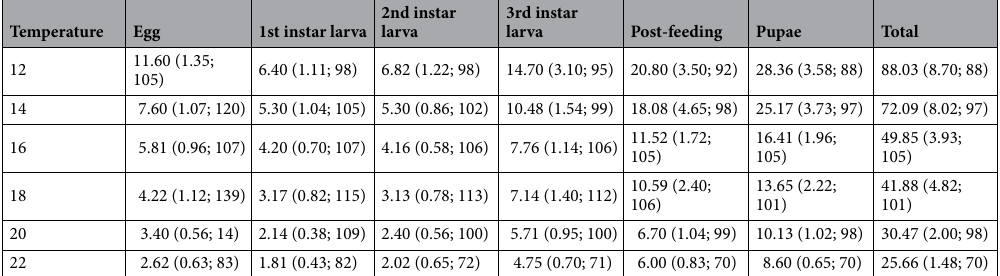
Table 2. Mean developmental times of T. rugosus at six constant temperatures for each developmental stage (days, °C). Standard deviation followed by the number of observed specimens shown in parentheses ( SD; N ).